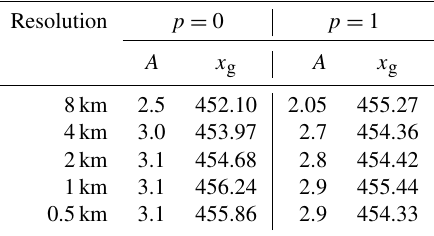
Table 6. Ice softness A (10 − 18 Pa − 3 yr − 1 ) and resulting grounding line position x g (km) at the end of the spin-up for the slow-moving ice shelf experiment. Note that the A values are not